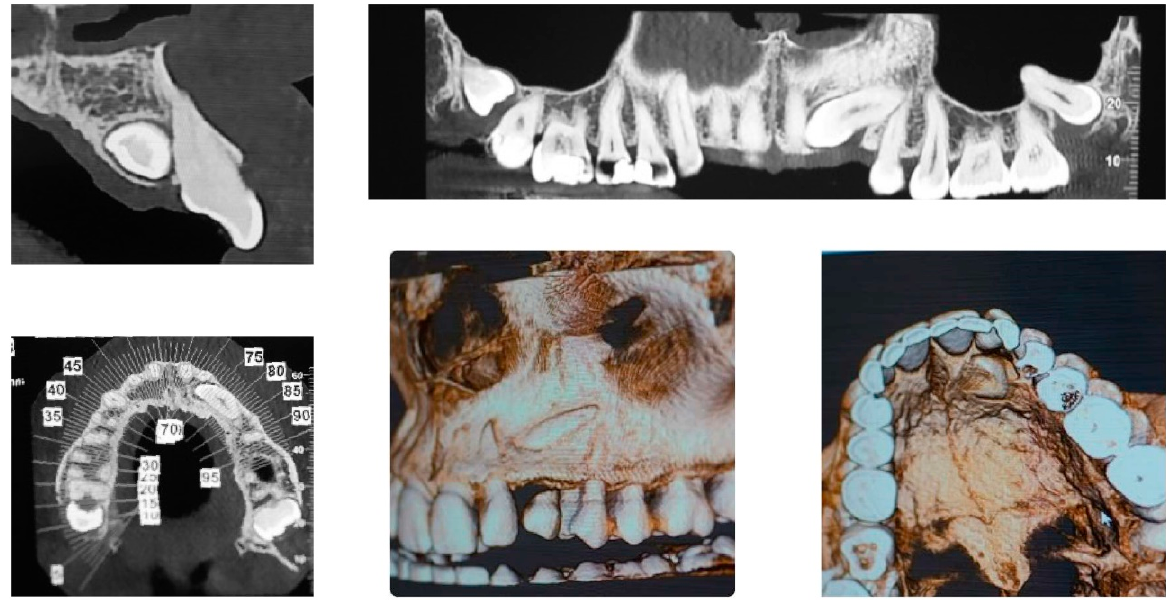
Figure 10. CBCT pictures of the patient. Since the patient was subjected to periodic radiographic control as she was a cancer survivor, the decision was to do a CBCT to receive all the informations useful for the deimpaction treatment and avoid conventional orthodontic x-rays like panoramic and lateral x-rays.